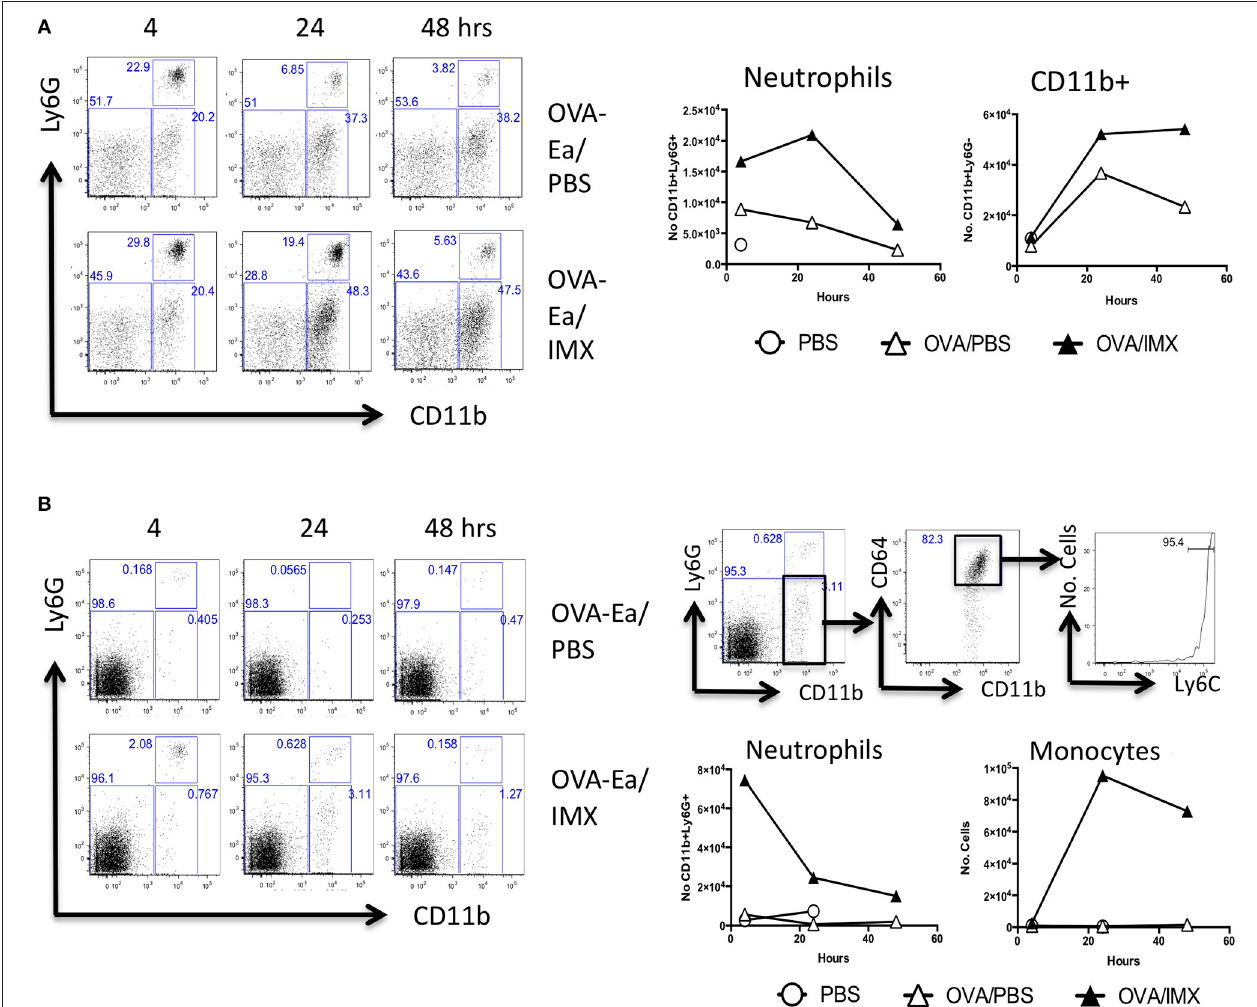
FIGURE 2 | Neutrophils and CD11b + cells are recruited to both the injection site and to the draining lymph node. (A) Representative flow cytometry plots showing the recruitment of neutrophils and CD11b + cells in the injection site at 4, 24, and 48h following immunization with OVA/PBS (top) or OVA/ISCOMATRIX (bottom). Absolute numbers are shown in the graphs on the right. (B) Representative flow cytometry plots showing the recruitment of neutrophils and CD11b + cells in the draining cervical lymph node at 4, 24, and 48h following immunization with OVA/PBS (top left) or OVA/ISCOMATRIX (bottom left). Further representative plots show the identification of the majority of the CD11b cells in the OVA/ISCOMATRIX treated lymph node at 24h were monocytes (CD64 + Ly6C high) (top right). Absolute numbers of Neutrophils and monocytes recruited to the draining lymph node in response to OVA/PBS and OVA/ISCOMATRIX are shown (bottom left). Data shown is from 3 mice per group pooled and is representative of 5 independent experiments. IMX = ISCOMATRIX TM